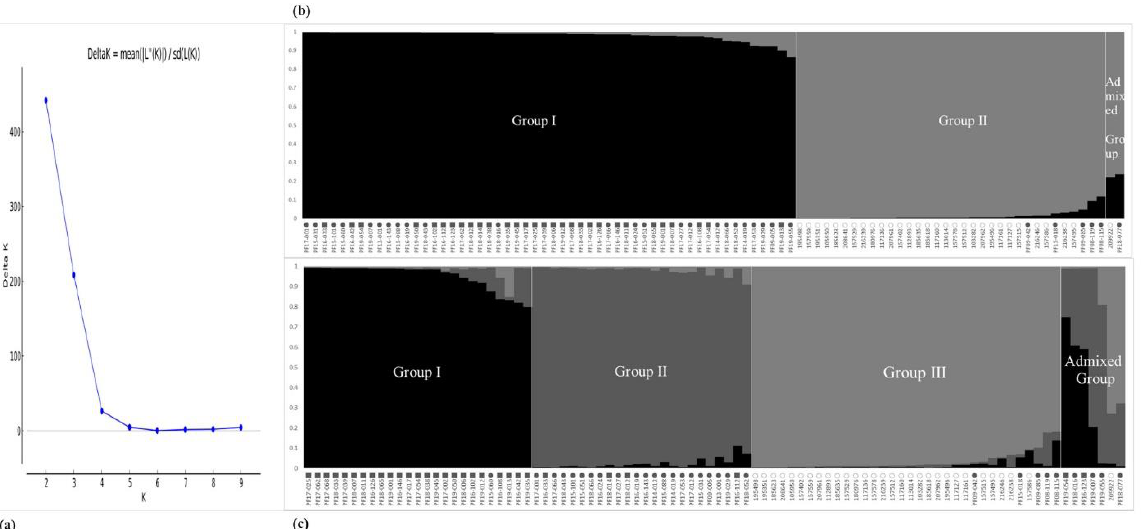
Figure 1. Magnitude of ∆K as a function of K ; the peak value of ∆K was at K = 2 ( a ). Population structure of 90 Perilla accessions collected from South Korea based on new 17 Perilla SSRs for K = 2 ( b ) and K = 3 ( c ); ○ : accessions of cultivated var. frutescens , ●: accessions of weedy var. frutescens , ■ : accessions of weedy var. crispa .